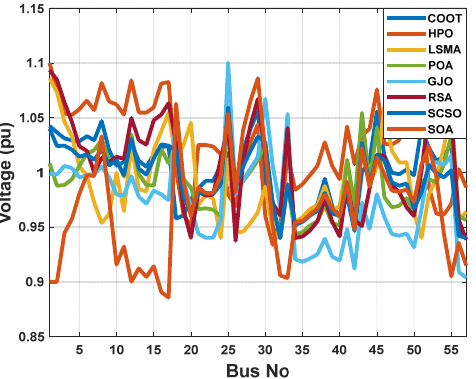
Figure 22. The convergence characteristics of POA and other compared algorithms for case 2 in a standard IEEE 57-bus test system.